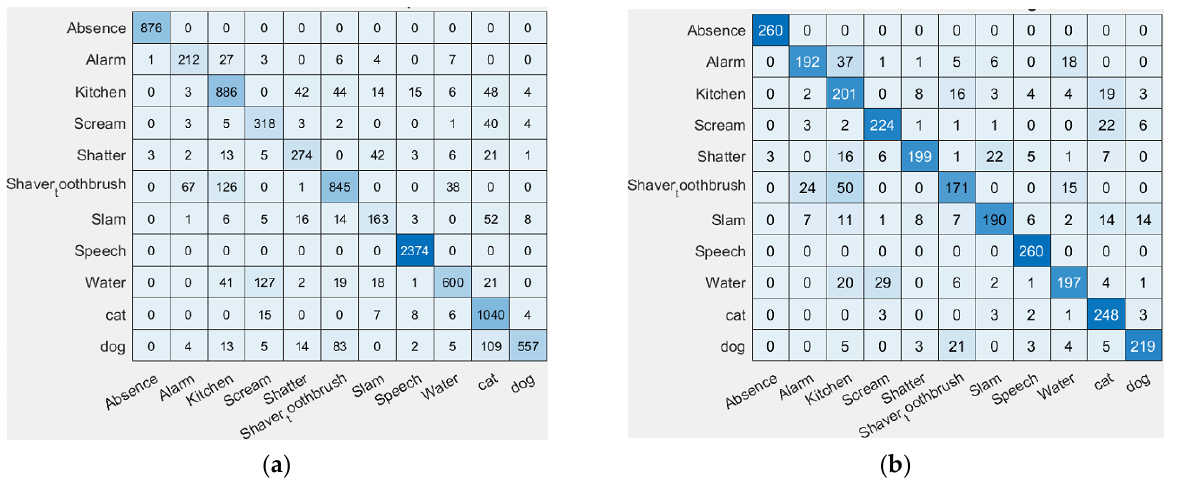
Figure 5. Confusion matrices for the top performing algorithm—CWTFT scalograms for: ( a ) Imbalanced dataset using the full synthetic database; ( b ) balanced dataset with 1565 files for training, and 260 files for testing.